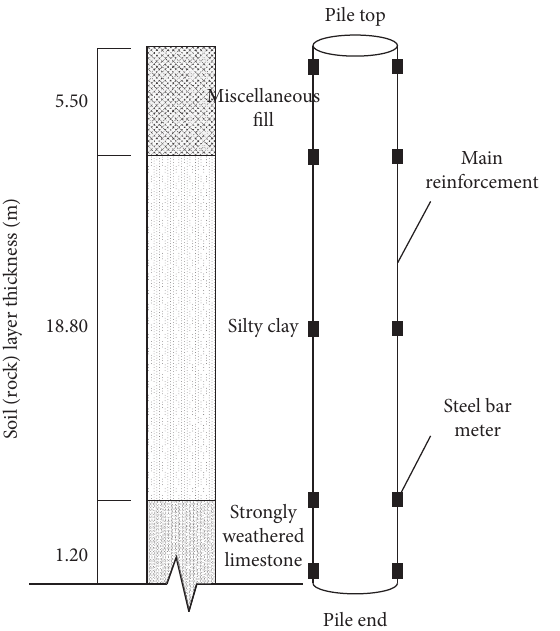
Figure 2: Cross section showing reinforcement meters on test